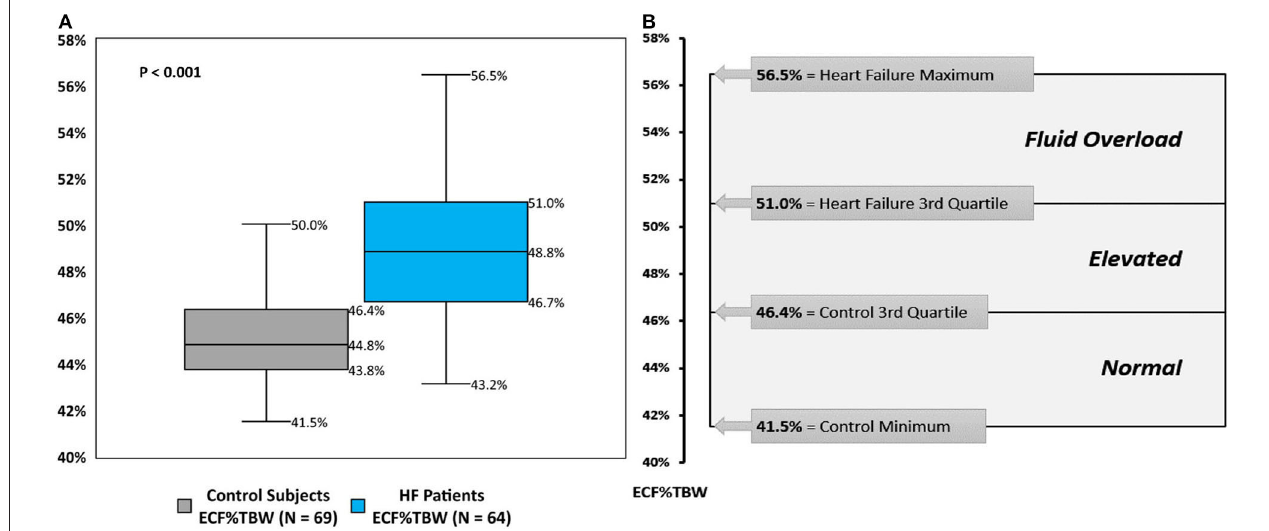
FIGURE 3 | Extracellular fluid percentage of total body water; box-and-whisker plots (A) , and clinical strata (B) . (A) box-and-whisker plots for bioimpedance spectroscopy-derived extracellular fluid percentage of total body water (ECF%TBW) for Healthy Control Subjects (CON-pop, gray plot) and Heart Failure Patients (HF-pop, blue plot). (B) Normal, bottom three CON-pop quartiles; Elevated, bound by CON-pop 3rd quartile and HF-pop 3rd quartile; Fluid Overload, highest HF-pop